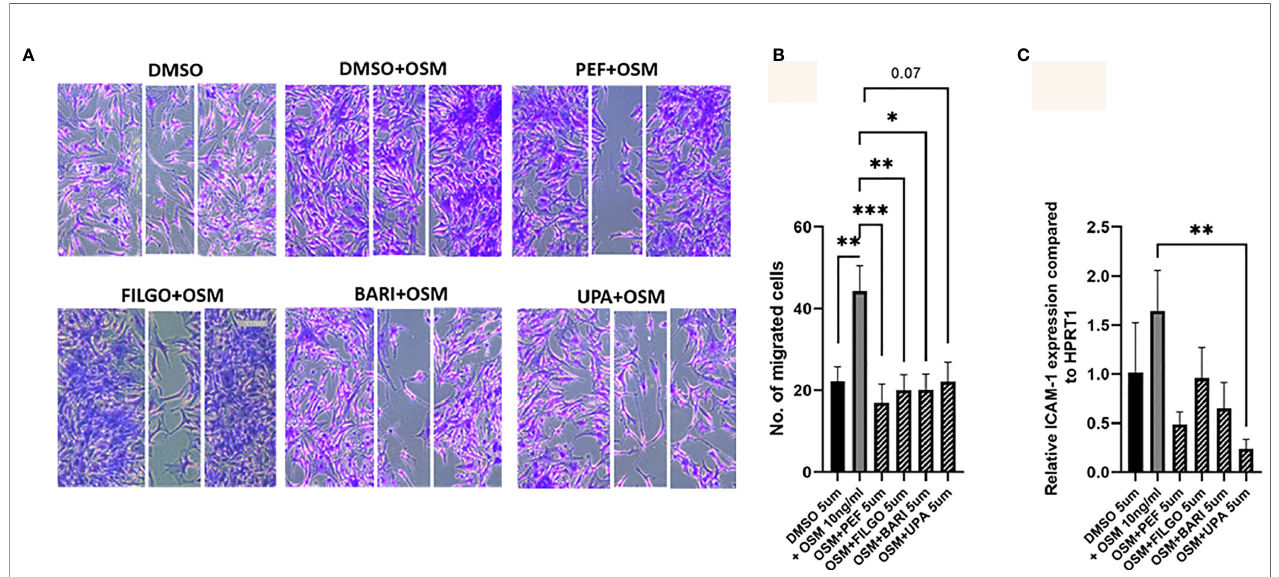
FIGURE 6 | JAKi inhibit OSM induced migration of PsAFLS. (A) Representative photomicrographs and (B) bar graph showing PsAFLS migration following treatment with JAKi (5 µM) or DMSO (5 µM) for 1 hr and stimulated with OSM (10 ng/ml) for 24 h, n=8 (magni fi cation X10). (C) Gene expression analysis of ICAM by real-time PCR (n=5). Values expressed as mean +/- SEM. * p <0.05, ** p <0.01, *** p <0.001 signi fi cantly different from DMSO+OSM